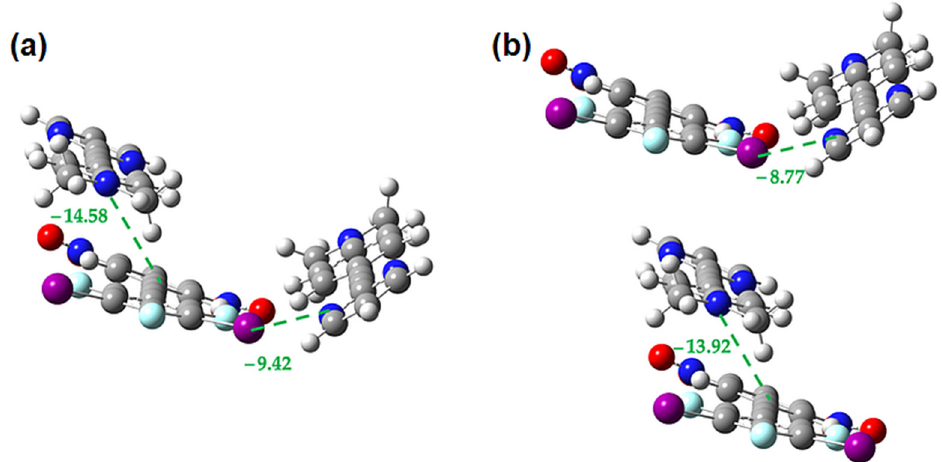
Figure 21. M062X-D3/DGDZVP interaction energies (in kcal/mol) in the 2 • 3 cocrystal for the interplay between the offset 2-3 π -stacking and the bent halogen bond ( a ) within trimer ( b ) in the isolated dimers.